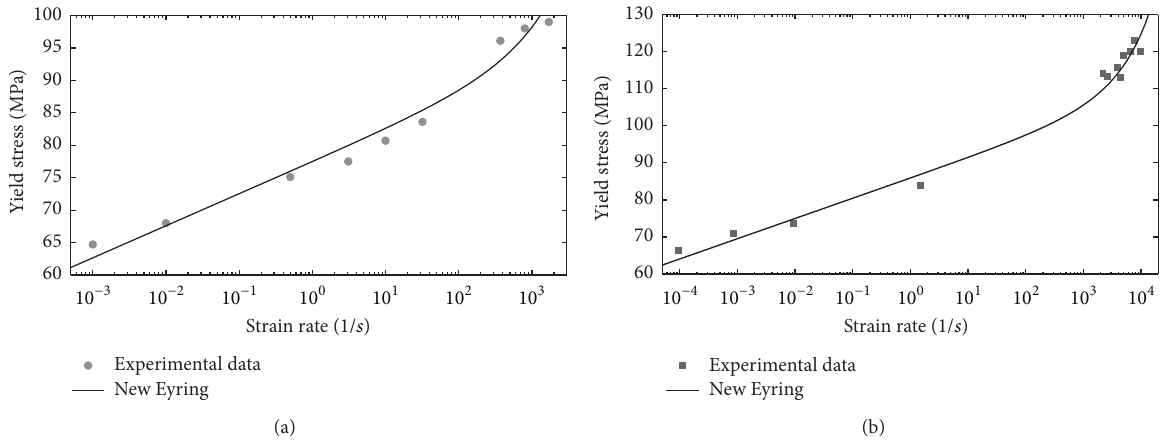
Figure 5: Experimental yield stress of PC fitted by the modified-Eyring equation: (a) tension and (b) compression.